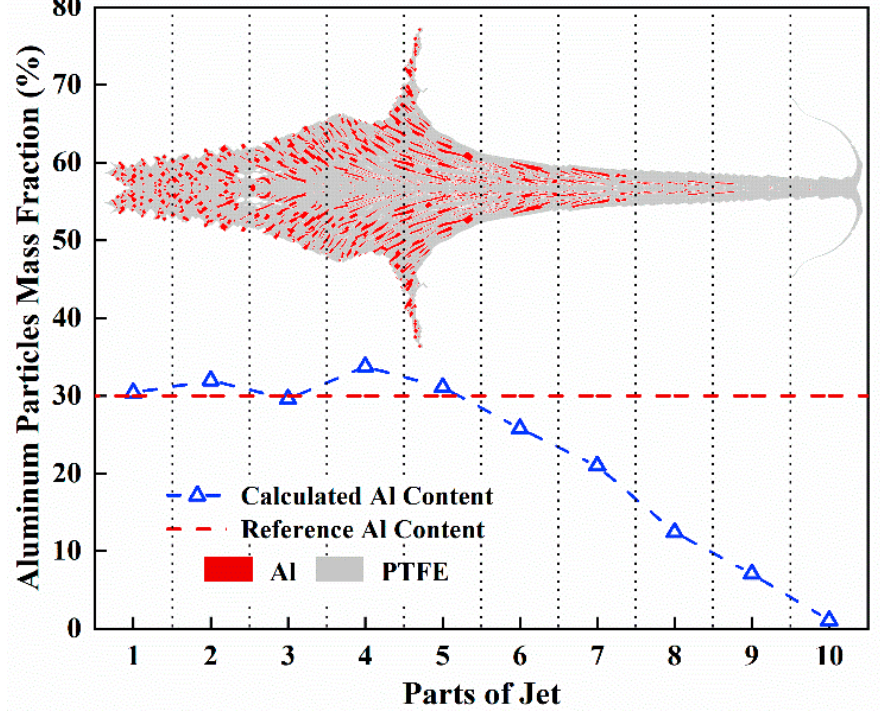
Figure 10. Aluminum particles mass distribution along the jet axis at 2 CD standoff.